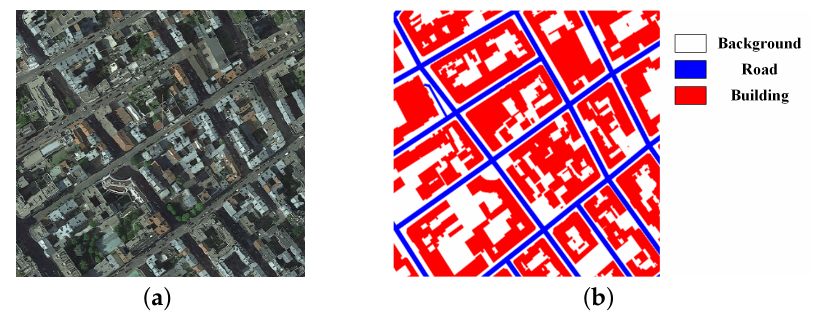
Figure 4. Potsdam-A data presentation; ( a ) original image; ( b ) label